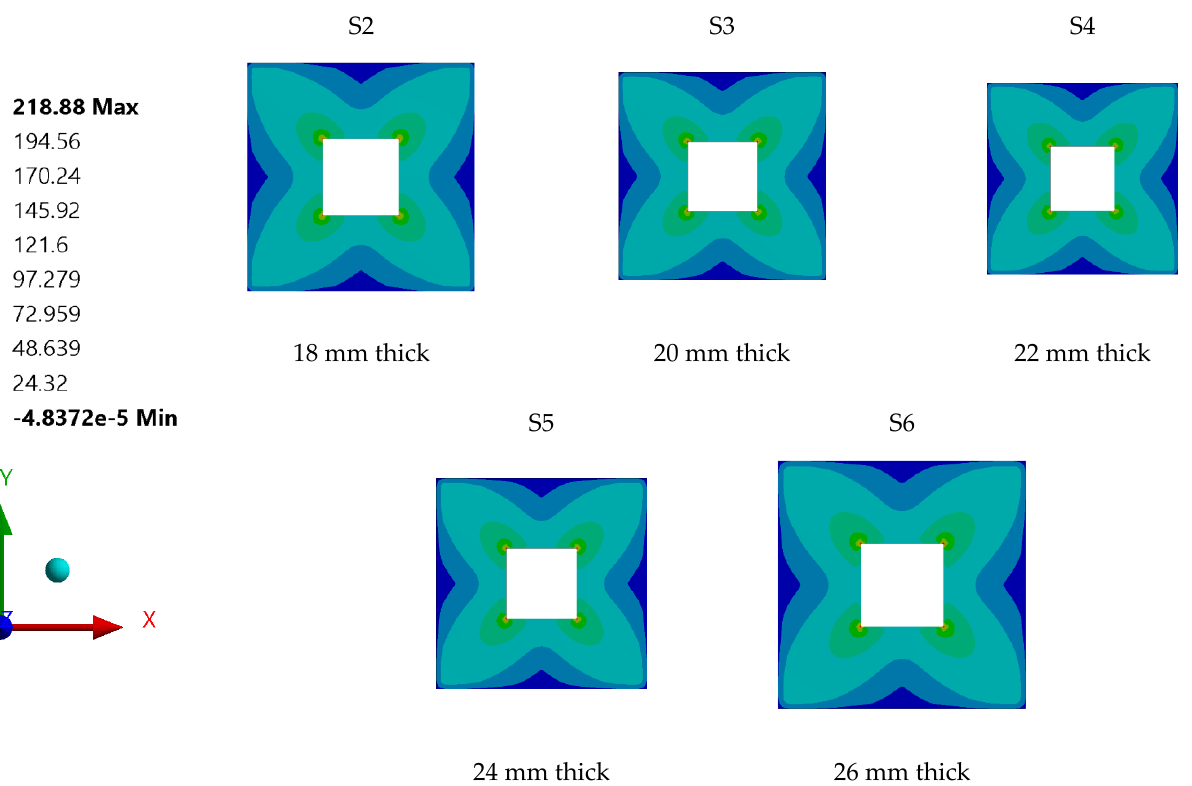
Figure 11. Stress distribution contours for individual steel plate specimens with varied wall thick- ness.